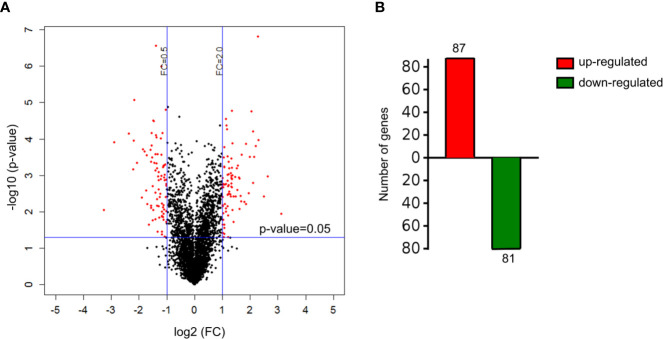
Differentially expressed proteins in HT-29 cells after Cd exposure. (A) volcano plots showing all detected proteins. The red dots represent the differentially expressed proteins after Cd exposure P-value of <0.05 with fold change of >2 or fold change of <0.5. The black dots are proteins with no significant changes. (B) the number of up-regulated and down-regulated genes responsible for differentially expressed proteins.